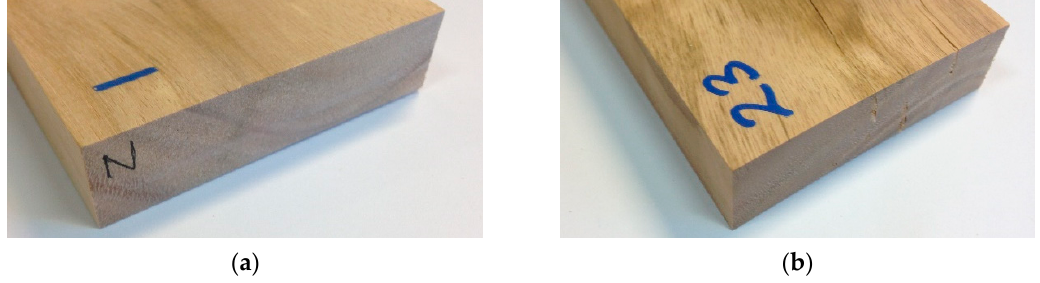
Figure 7. Examples of E. nitens with grades of G0 (excellent) ( a ) and G2 (good) ( b ) for routing end grain. Table 3. Grading results according to routing end grain.